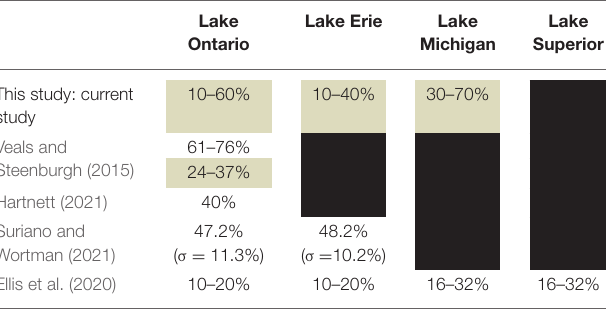
TABLE 2 | LES snowfall contributions to seasonal snowfall for different regions downwind of the Great Lakes reported by recent studies.